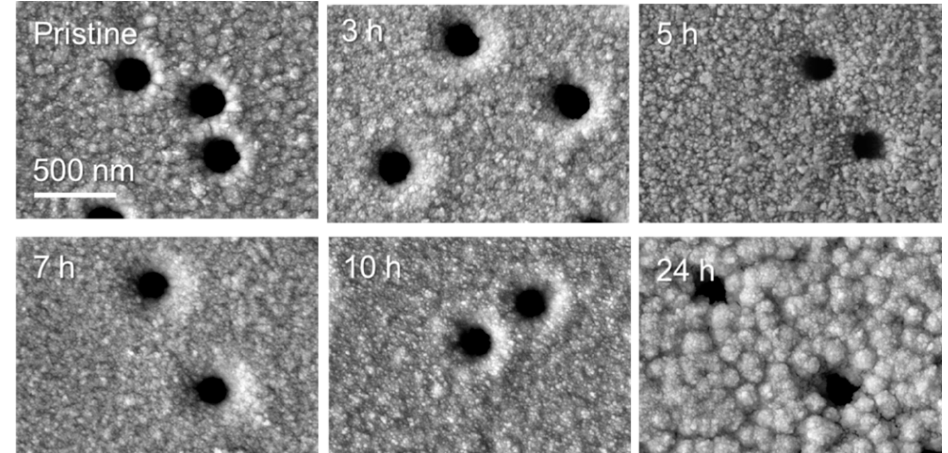
Figure 4. SEM images of the composite membrane after thermal annealing at 140 °C for various times.